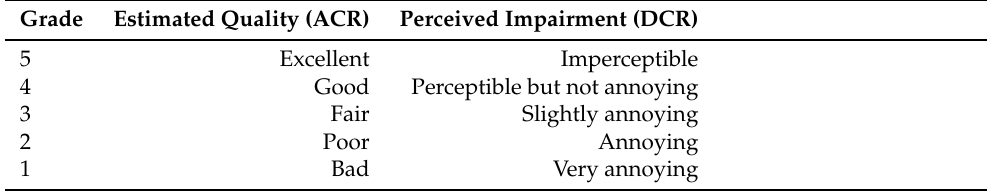
Figure 10. Outline of QoE assessment system for OTT TV service. The red shape indicates the unsupervised part. Table 4. ITU-T 5 point ACR and DCR